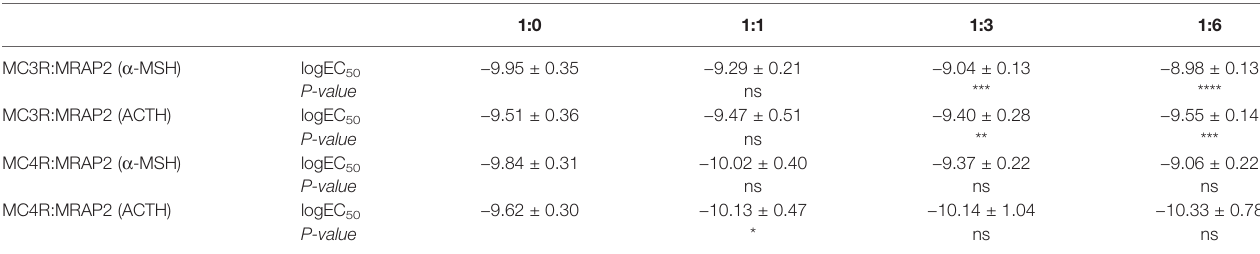
TABLE 1 | EC 50 values of a -MSH and ACTH in activating axolotl MC3R/MC4R in presence of different amounts of axolotl